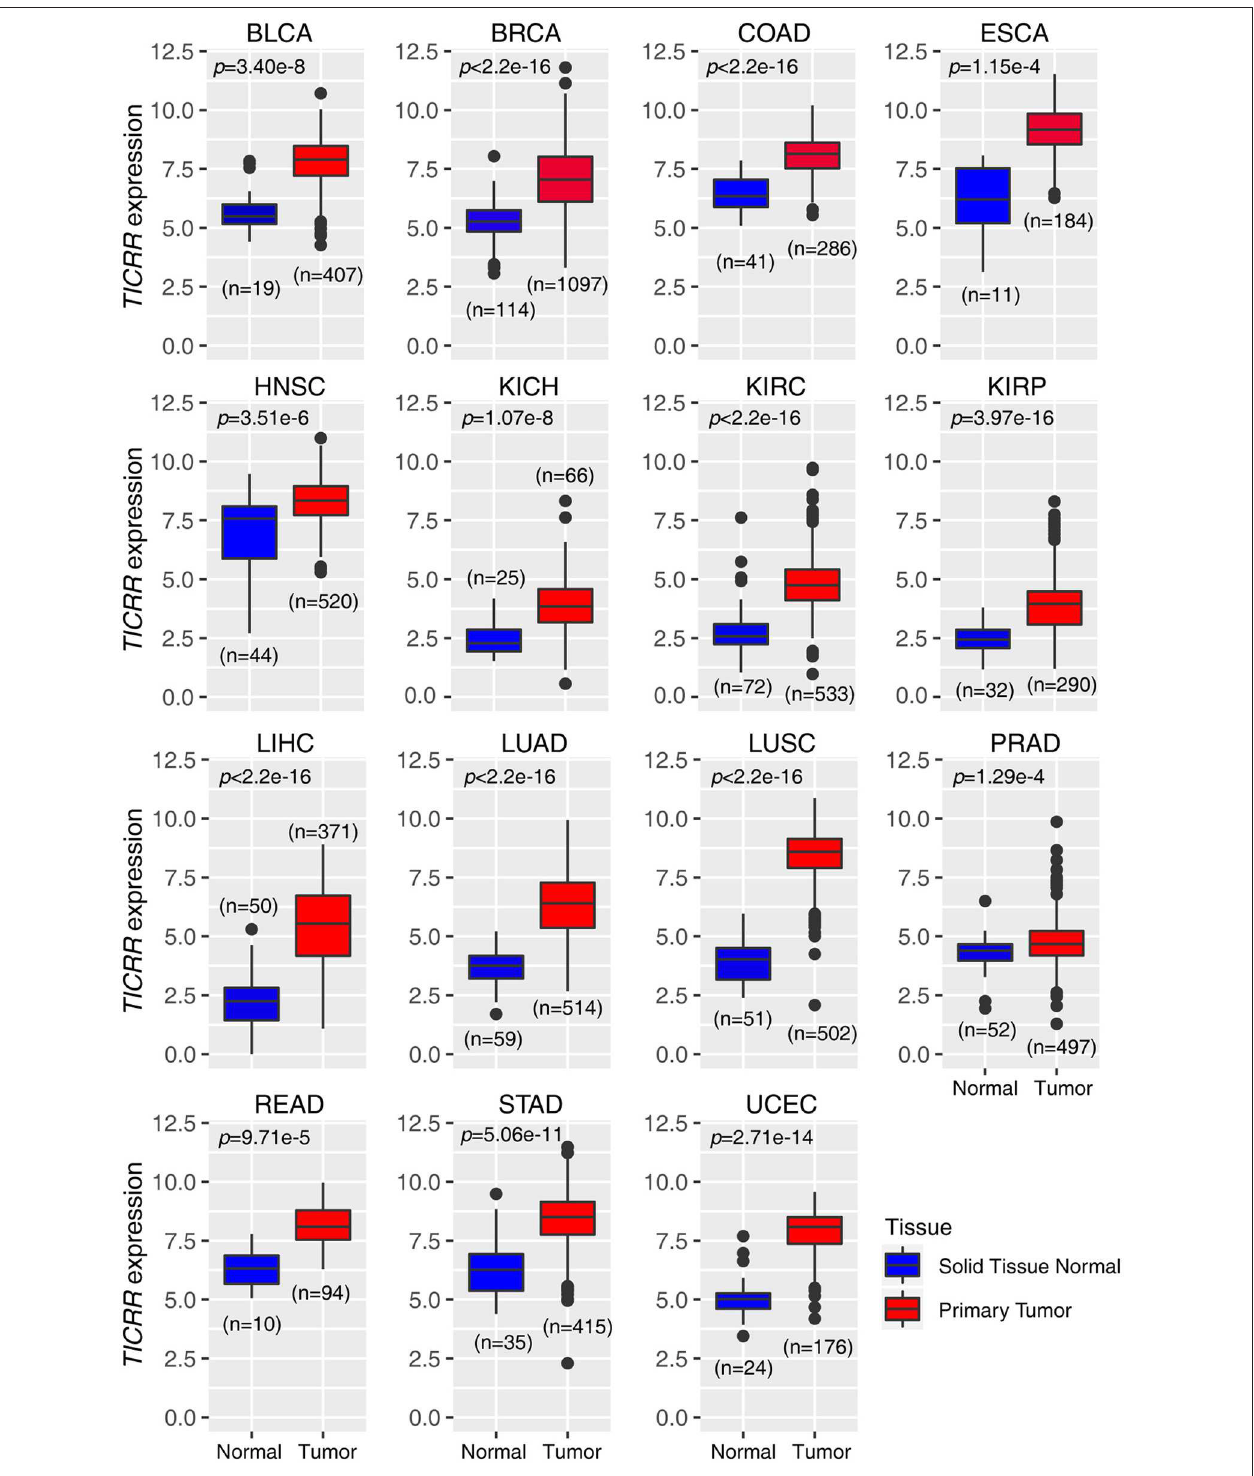
FIGURE 1 | Expression patterns of TICRR across 15 tumor types. The expression of TICRR was shown as log2(norm_count + 1). P -values were determined as two-tailed Student’s t -test. Data from The Cancer Genome Atlas were downloaded at https://tcga.xenahubs.net. BLCA, bladder urothelial carcinoma; BRCA, breast invasive carcinoma; COAD, colon adenocarcinoma; ESCA, Esophageal carcinoma; HNSC, head and neck squamous cell carcinoma; KICH, kidney chromophobe; KIRC, kidney renal clear cell carcinoma; KIRP, kidney renal papillary cell carcinoma; LIHC, liver hepatocellular carcinoma; LUAD, lung adenocarcinoma; LUSC, lung squamous cell carcinoma; PRAD, prostate adenocarcinoma; READ, Rectum adenocarcinoma; STAD, Stomach adenocarcinoma; UCEC: uterine corpus endometrial carcinoma.